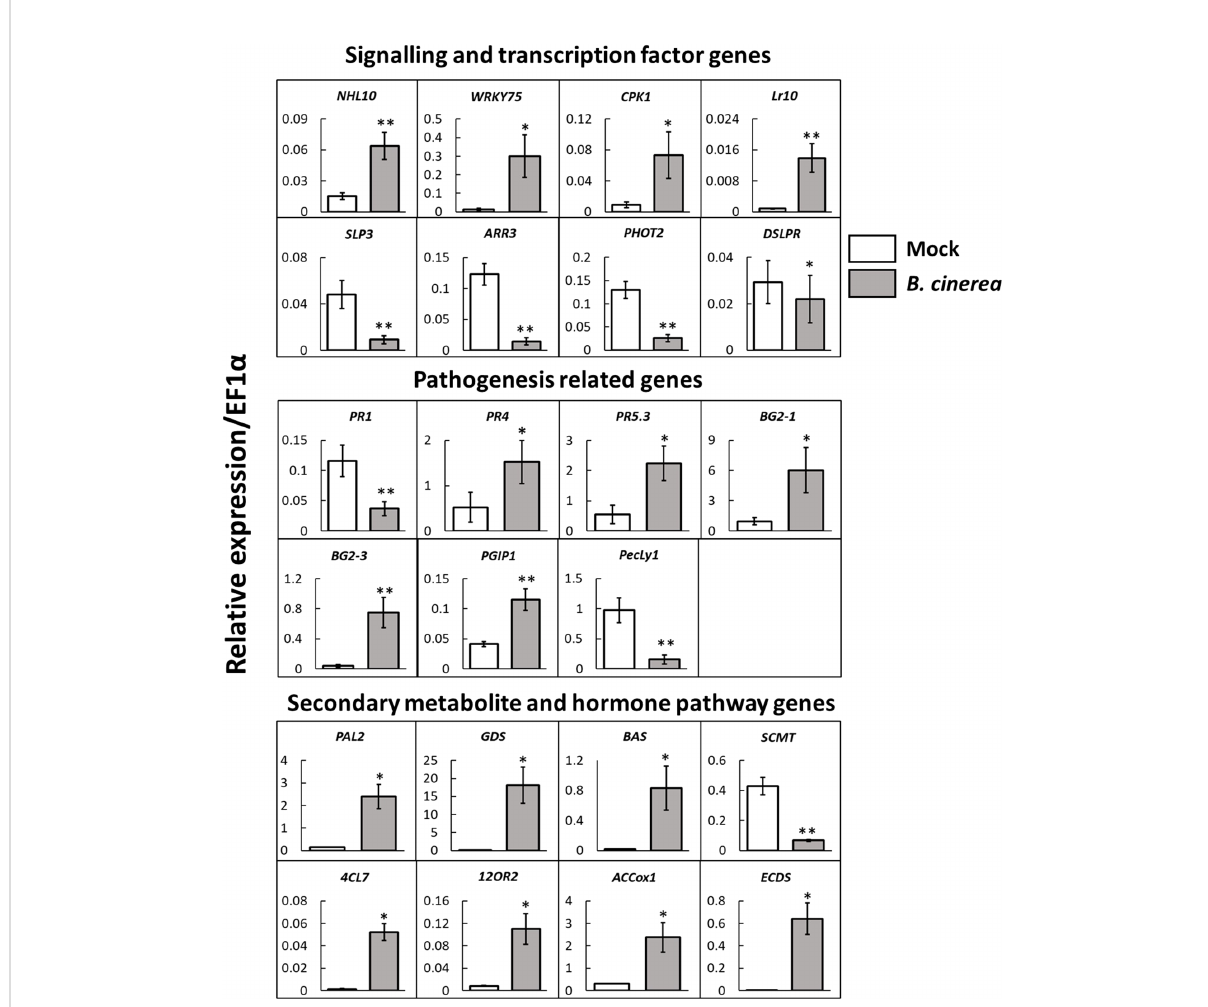
FIGURE 2 Validation of expression levels by qRT-PCR of selected genes in leaves of Fragaria vesca infected with Botrytis cinerea . White bars; mock- infected plants, grey bars; plants infected with B cinerea . The housekeeping gene EF1 a was used as an endogenous control gene and expression values were calculated using the D Ct method. n = 5 plants per treatment. Error bars show standard error ( ± 1 SE). Student ’ s t-test: * p < 0.05 , **p < 0.01